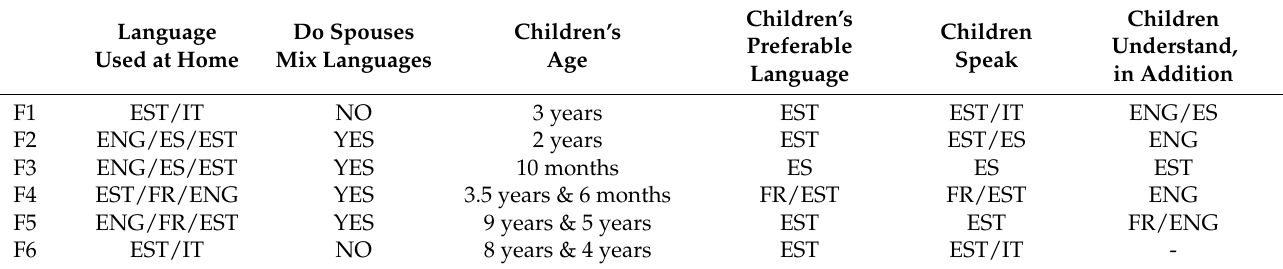
Table 2. Language availability of family members.